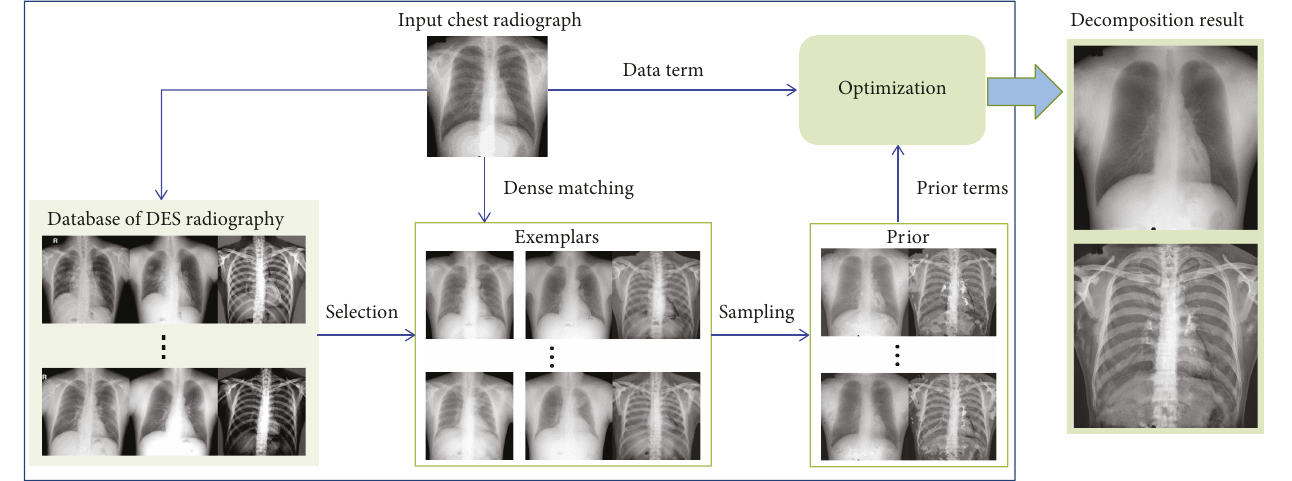
Figure 2: Flowchart of the proposed method for decomposition of a chest